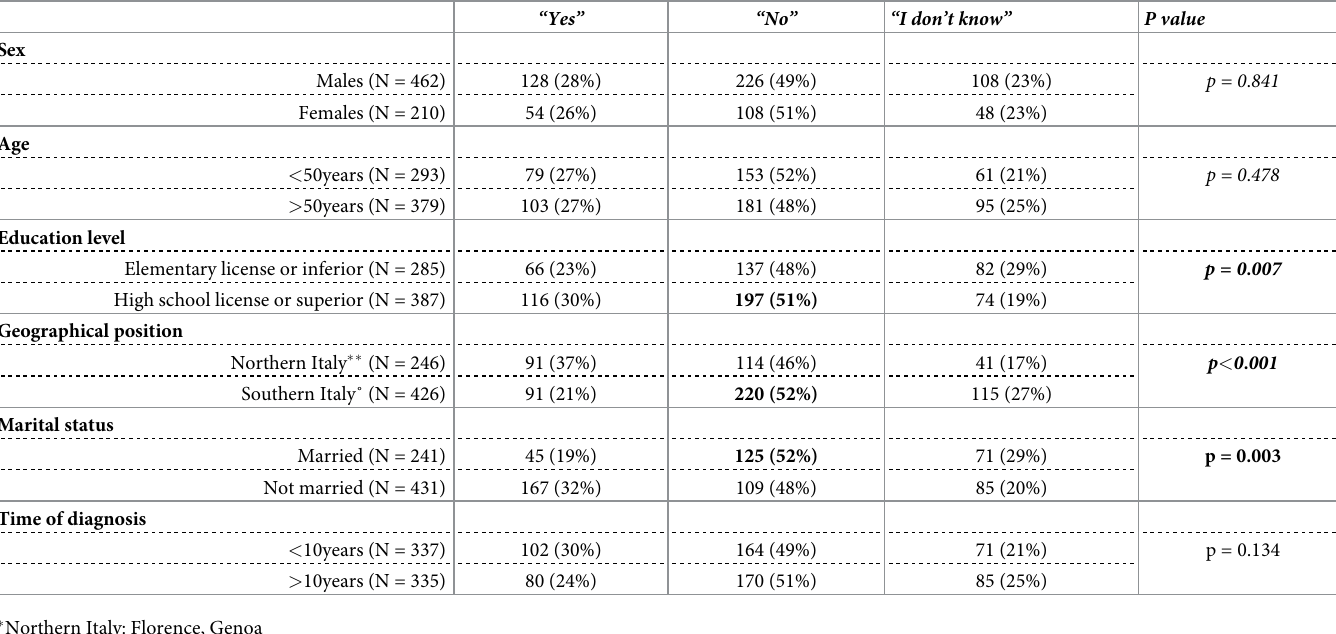
Table 3. Patient’s subjective perception of the disease according to socio-demographic variables.